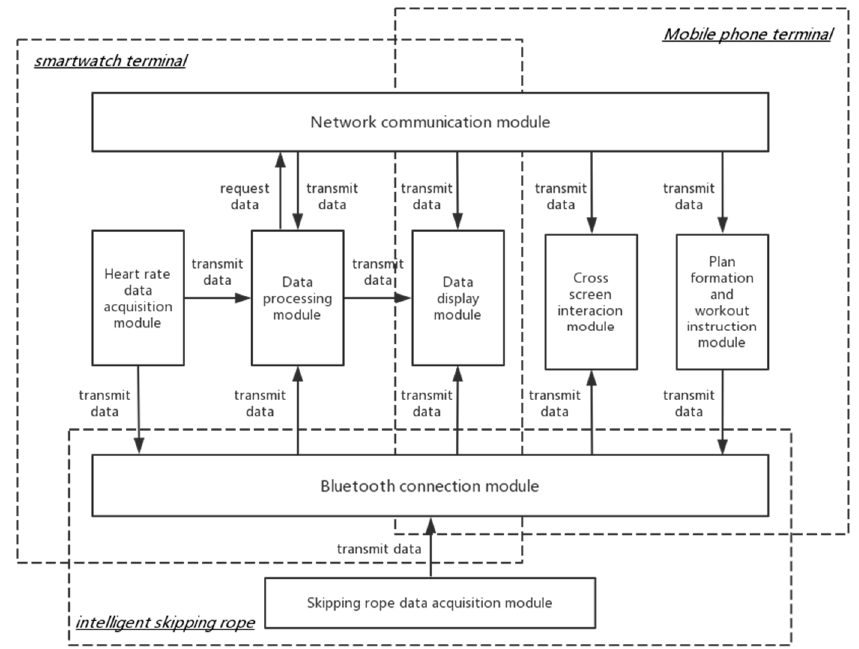
Figure 7. Multi-terminal skipping rope service system framework.